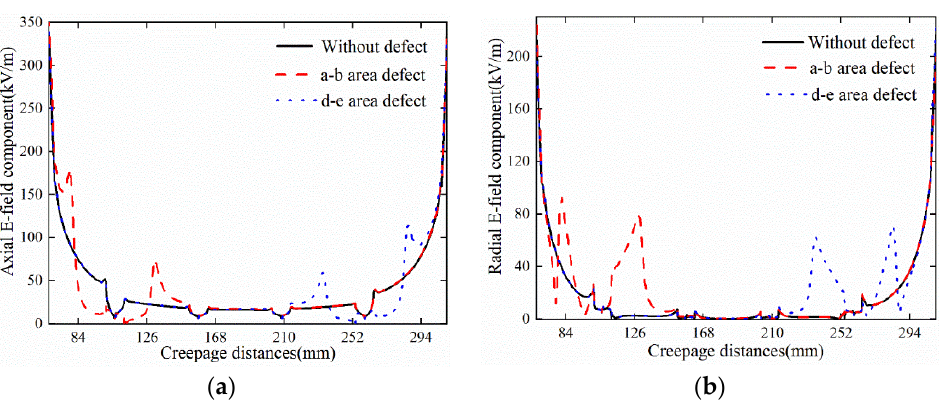
Figure 6. Electric field potential distribution of the composite insulators with internal defects be- tween “ a ” − “ b ”.